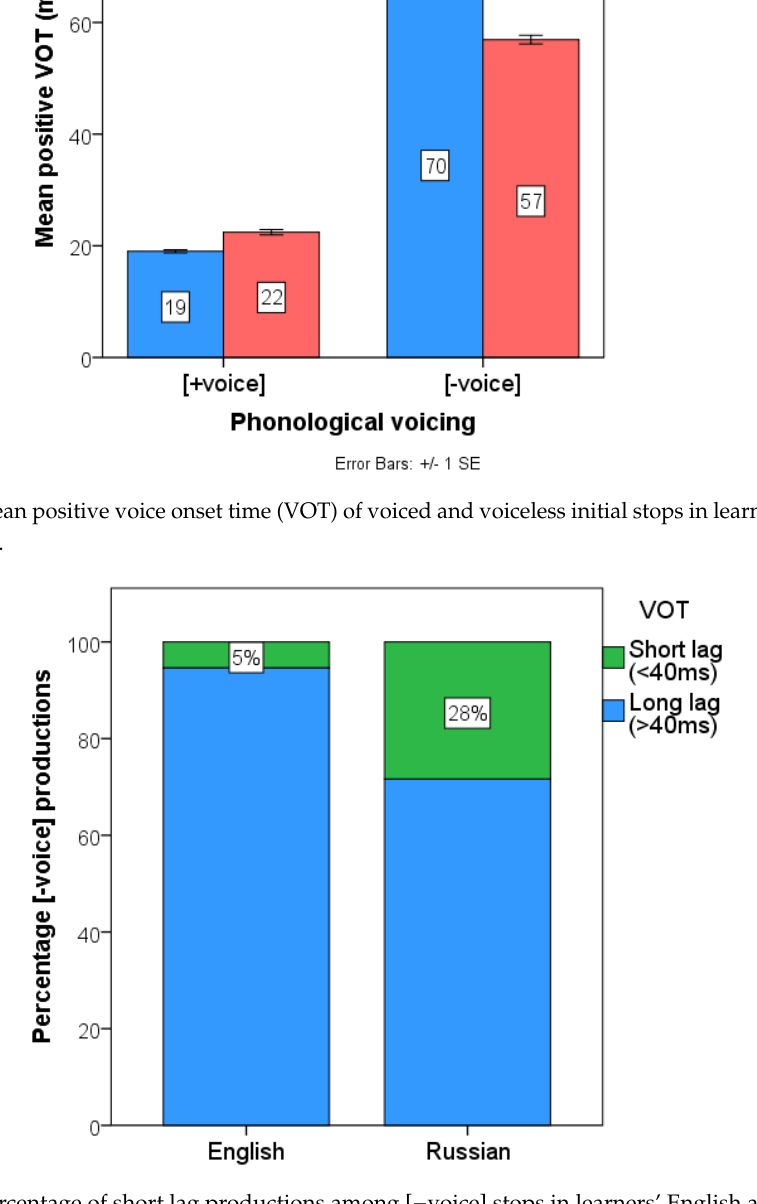
Figure 2. Percentage of short lag productions among [ − voice] stops in learners’ English and Russian.